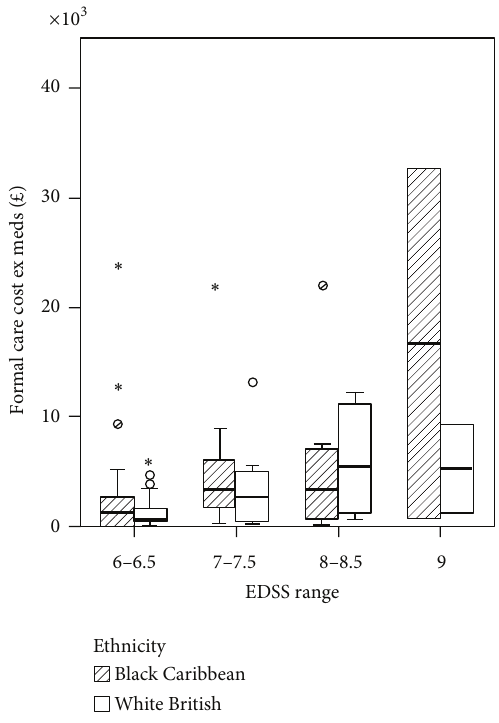
Figure 7: Box plot of formal care costs for Black Caribbean and White British groups.